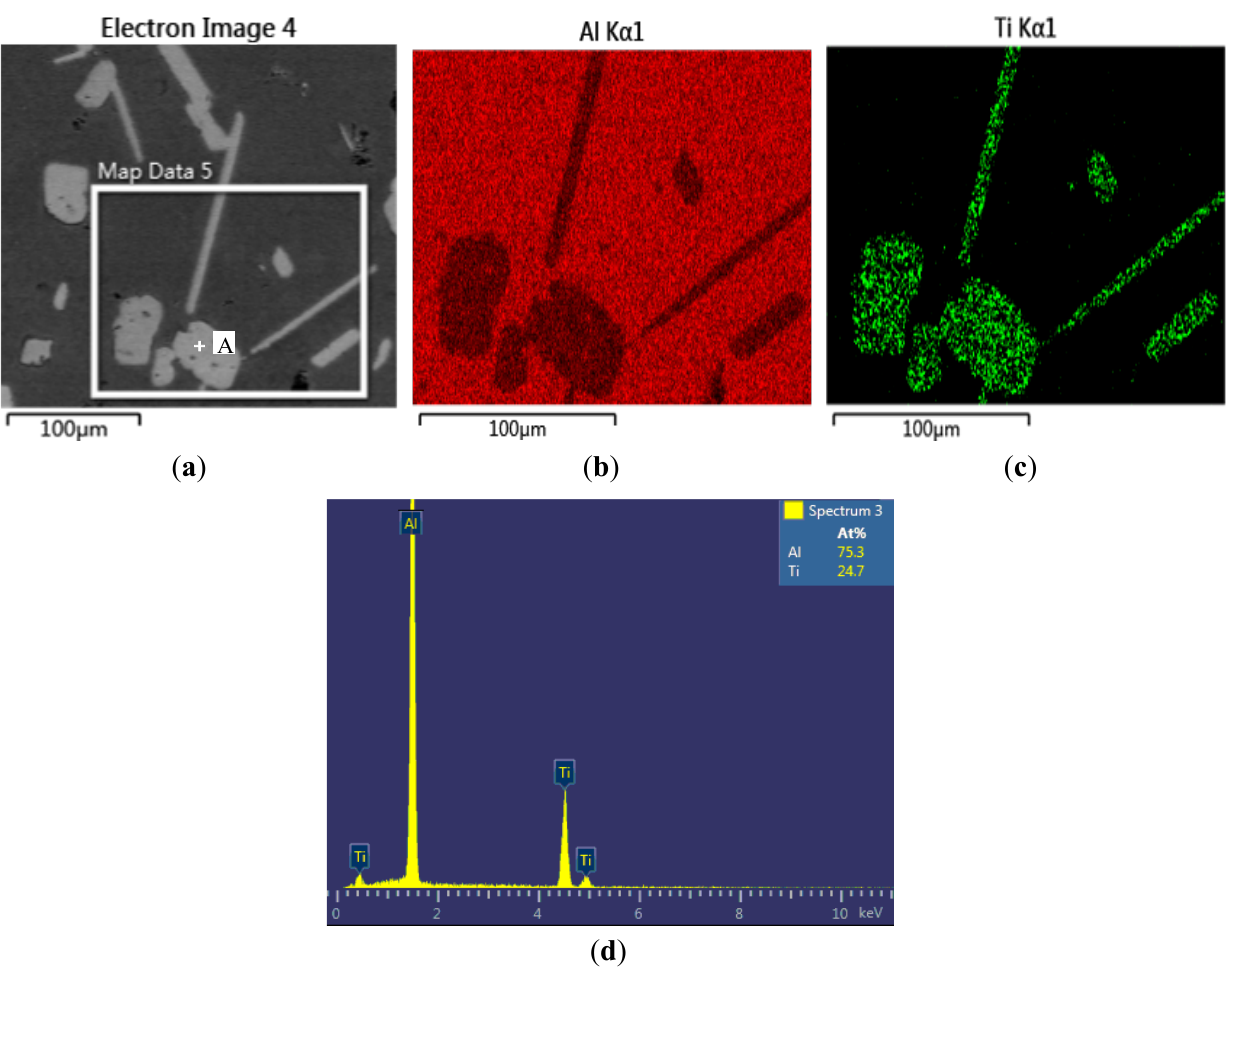
Figure 3. High power SEM image of Figure 1b and elemental maps and EDS analysis of particles: ( a ) SEM image; ( b ) Al element; ( c ) Ti element; master alloy 2 # with mixed TiAl 3 ( d ) EDS analysis of point A in Figure